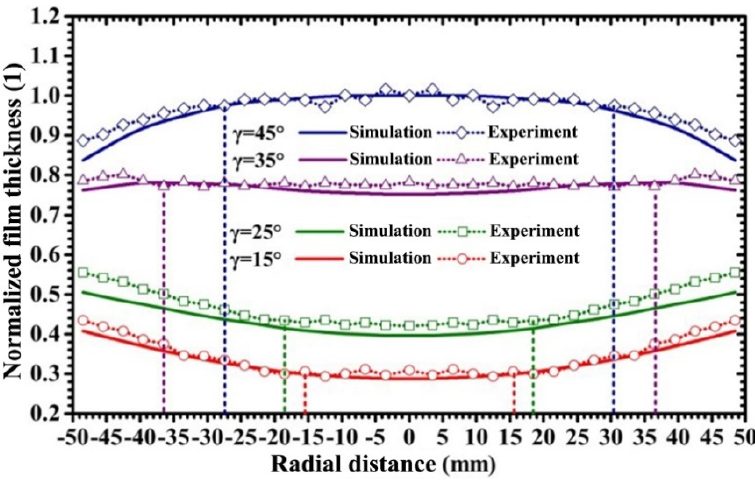
Figure 5. Normalized film thickness distribution curves under various target-substrate angles.